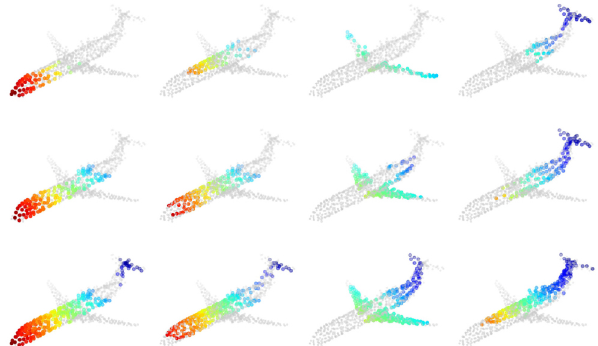
Fig. 5 Representative structures learned by the decoding network. Local patches in the 2D structured point cloud ¯ P c correspond to local point regions, which grow with increasing patch size from the top row to the bottom